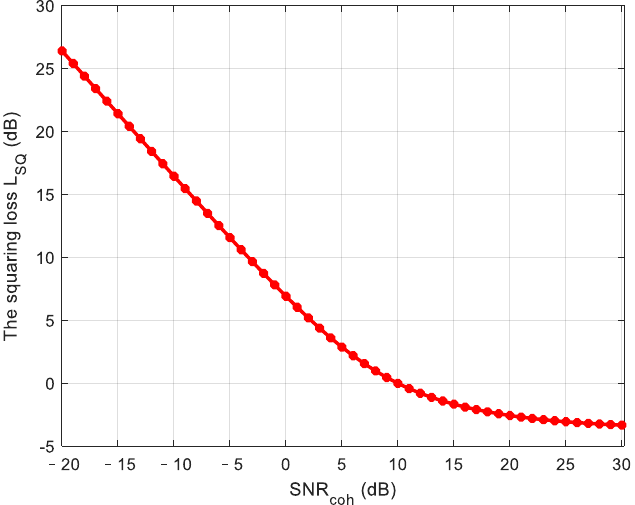
Figure 8. The squaring loss of non-coherent integration.